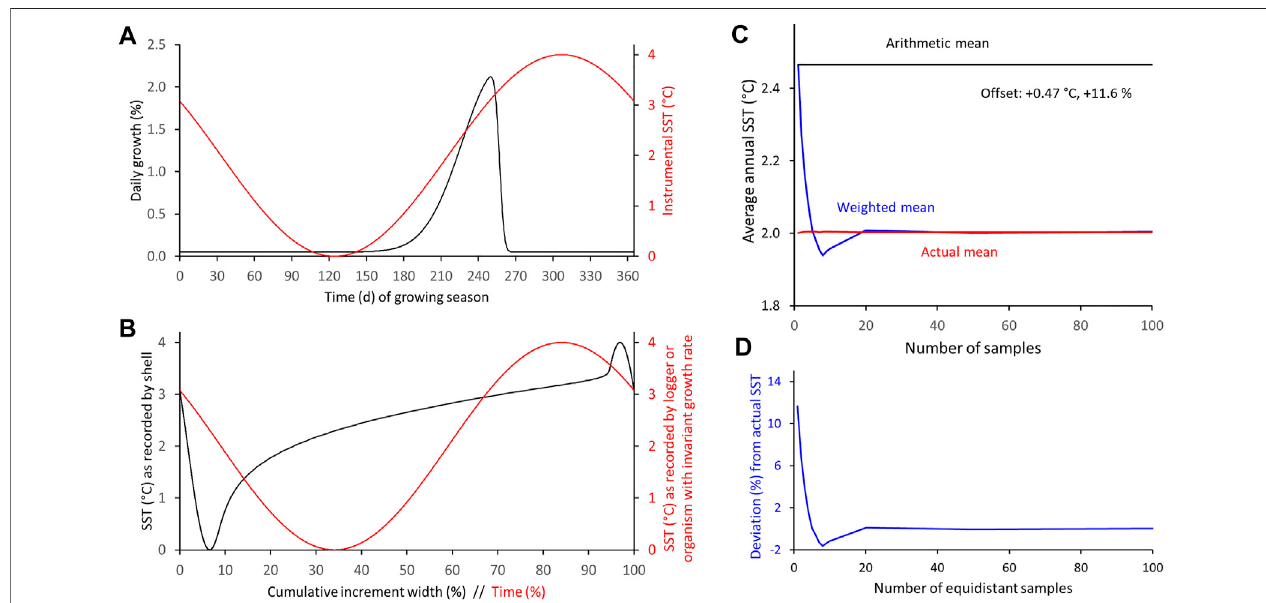
FIGURE 11| Numerical simulation of differences between arithmeticand weighted annual means computed from intra-annual proxy-SSTassuming main growing season (fast growth) is limited to about 3 months, maximum shell growth occurs half-way between SST extremes, growth curve is left-skewed and SST curve has a symmetrical shape. (A) Modeled seasonal shell growth and SST. (B) SST as recorded by model shell and logger. (C,D) Arithmetic and weighted annual proxy-SST in comparison toactual SST mean. With increasing sample resolution, the weighted mean agrees better with the instrumental SSTaverage (C) : absolute values; (D) : relative values.